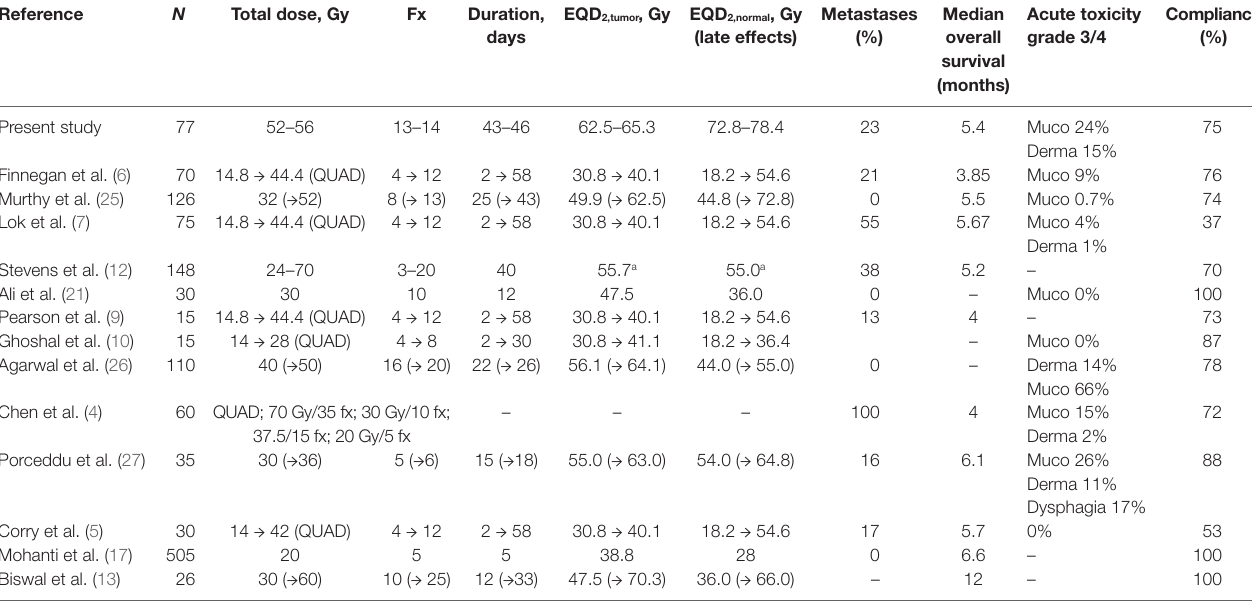
TaBle 4 | Studies reporting palliative hypofractionated radiotherapy to head–neck cancer patients (only studies with compliance data included). reference